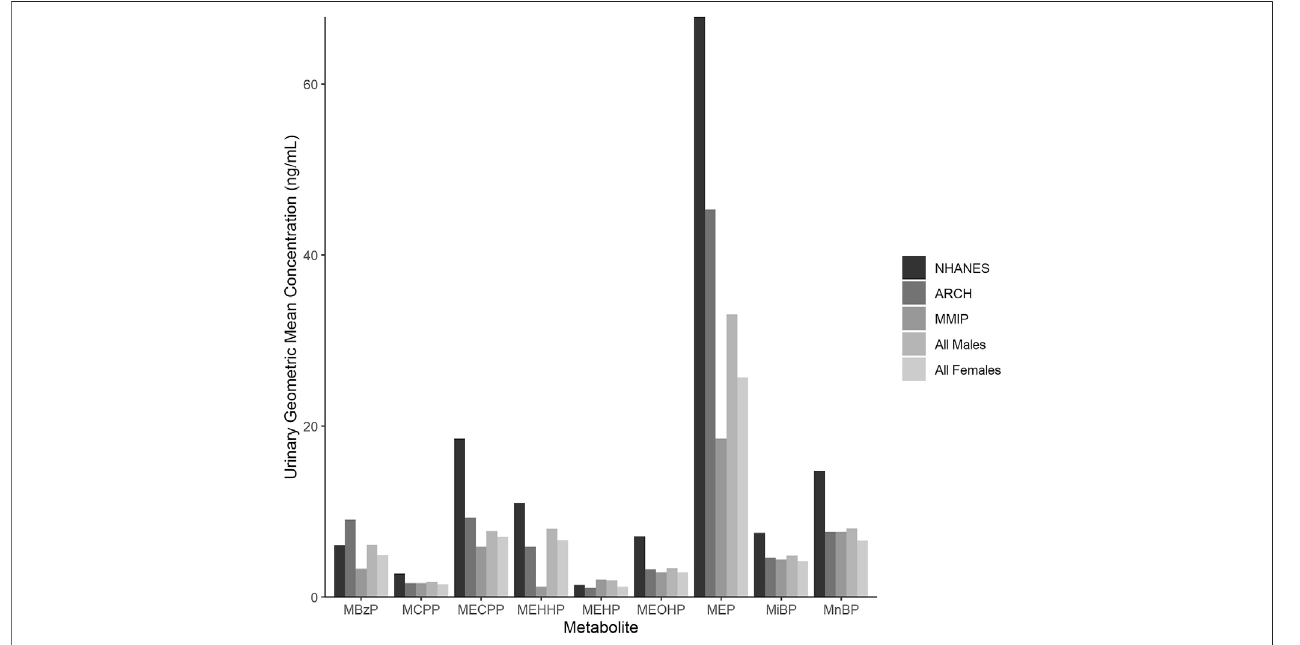
FIGURE 1 | Phthalate metabolite concentrations in urine from the National Health and Nutrition Examination Survey (NHANES), ARCH, and MMIP. Each bar represents the geometric mean of metabolites measured in NHANES, ARCH, and MMIP, as well as the combined ARCH and MMIP cohorts by infant sex.